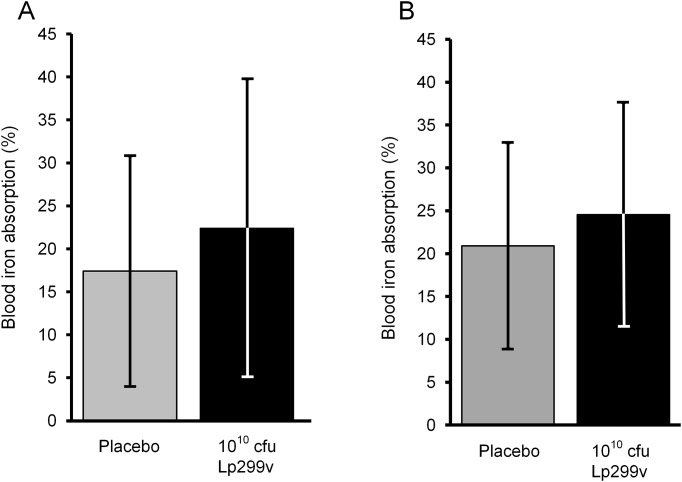
Iron absorption from a meal administered together with capsules with or without Lactobacillus plantarum 299v (Lp299v).Fig 3A: Study 1 (n = 14). Fig 3B: Study 2 (n = 28). The bars illustrate mean iron absorption and the whiskers cover the standard deviation (SD), and the dots illustrate individual subject data. Paired two-sample Student’s t-test was used to analyze differences between meals with or without Lp299v. Data were log-transformed before statistical analysis. Abbreviations: cfu, colony forming units.